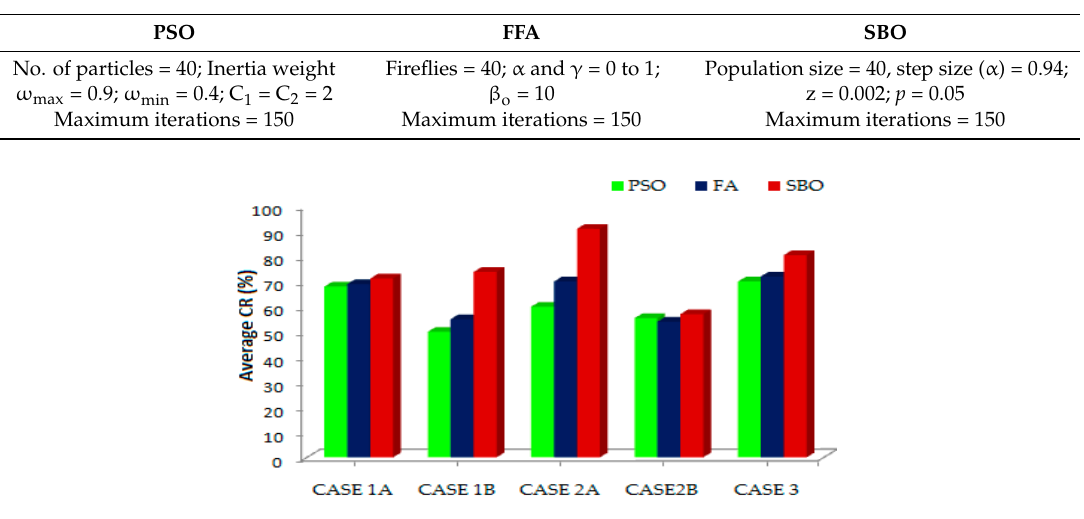
Figure 6. Average convergence rate (CR) values of the different cases.